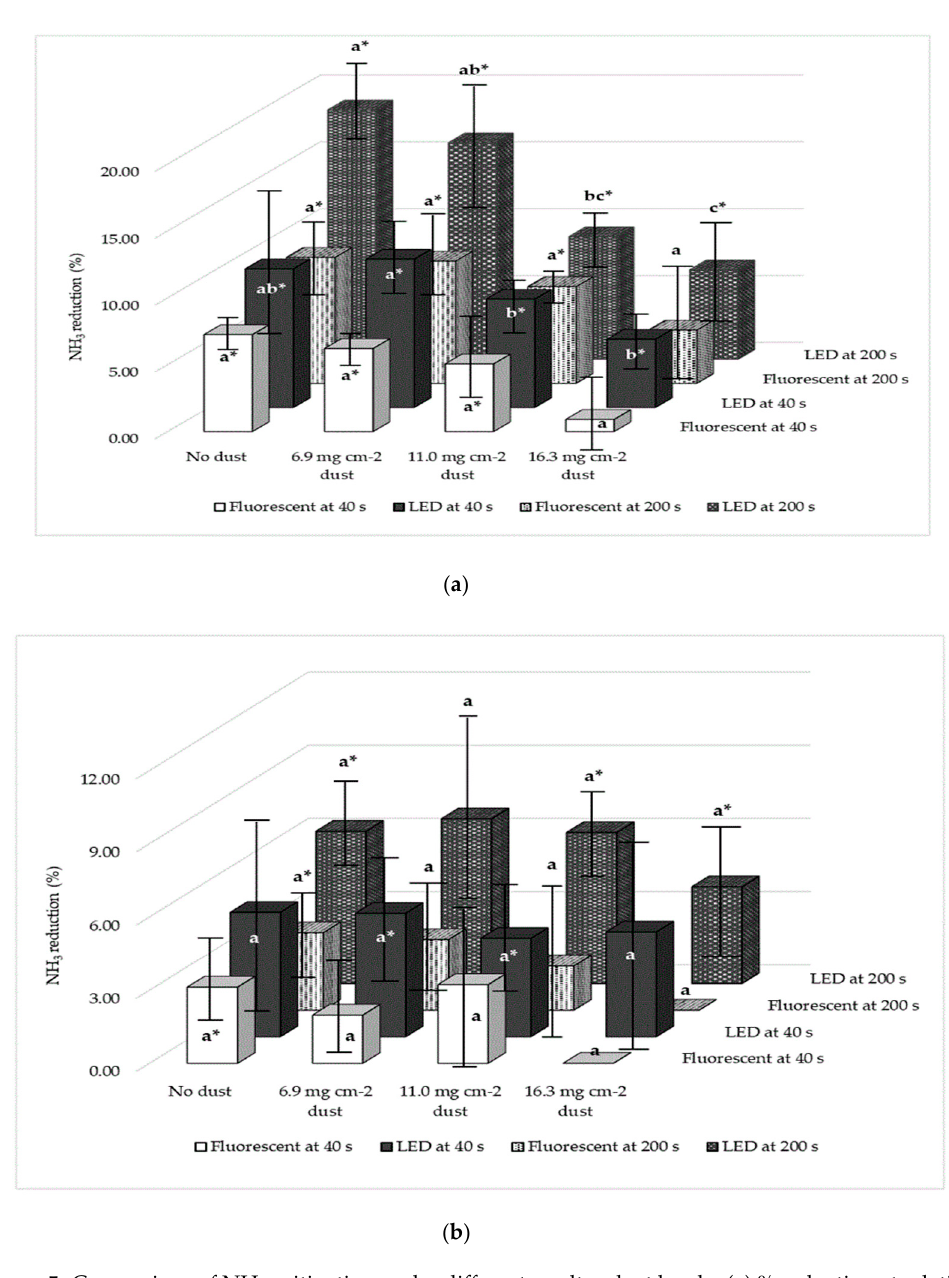
Figure 5. Comparison of NH 3 mitigation under di ff erent poultry dust levels. ( a ) % reduction at relative humidity of 12%; ( b ) % reduction at relative humidity of 60%; Superscript (*) signifies a statistical di ff erence compared to the control ( p < 0.05), and the di ff erent characters (a, b, c) signify statistical di ff erence at the same treatment time and the same light intensity ( p < 0.05). Error bars signify ± standard deviation. Table 2. Light absorption by accumulated dust and weight of accumulated poultry dust on TiO 2 .